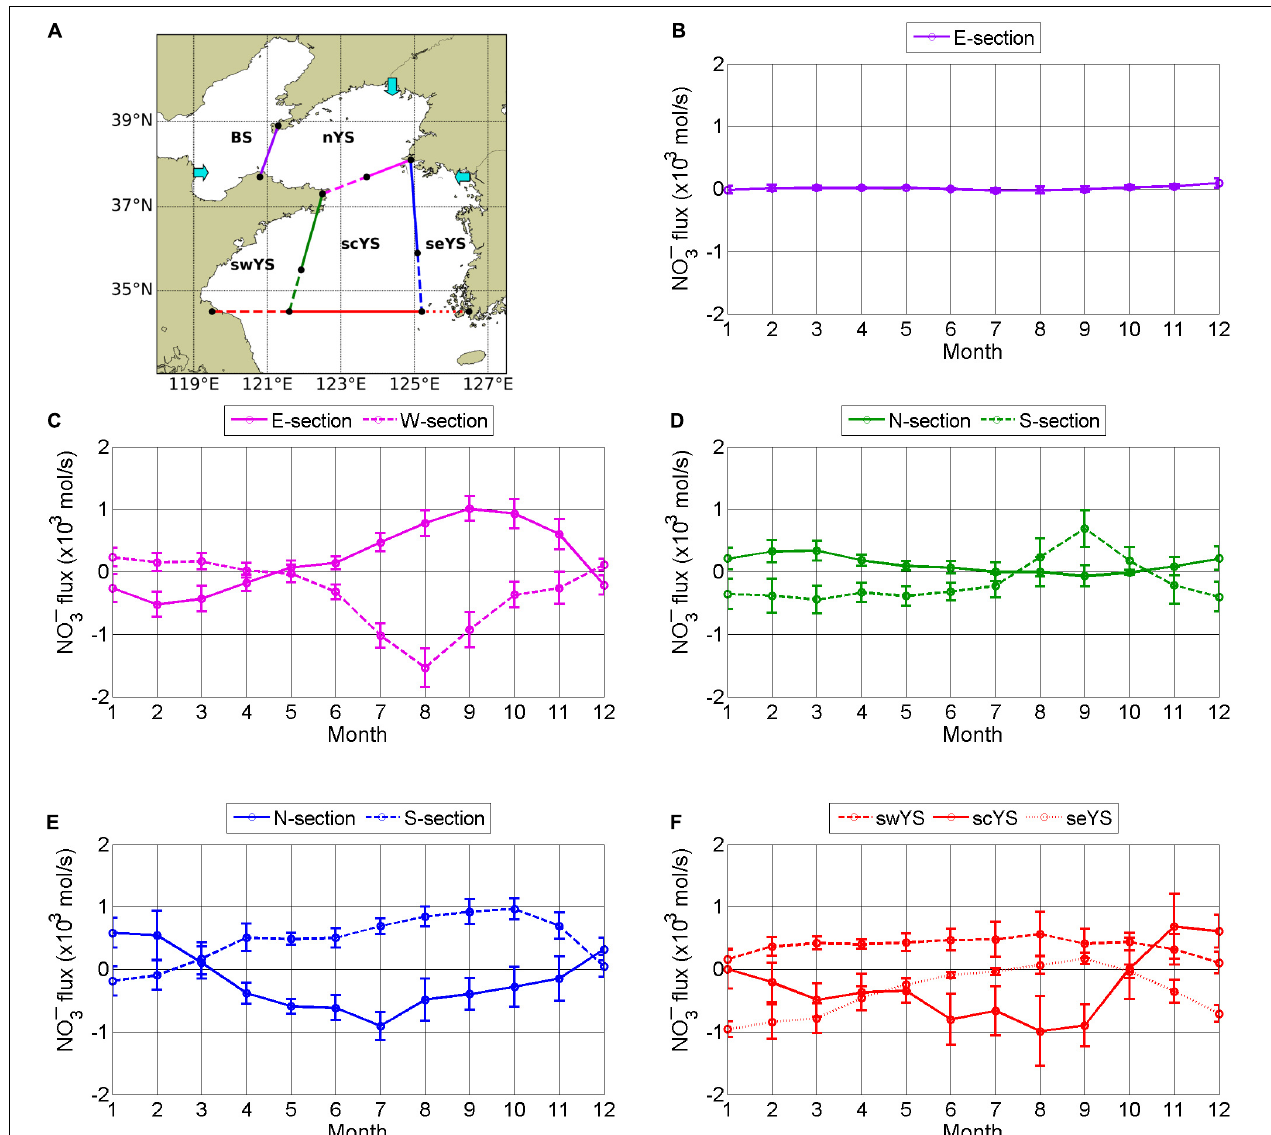
FIGURE 12 | Subregions (A) to estimate NO 3 − flux based on circulation in the YS. BS, nYS, swYS, scYS, and seYS denote the Bohai Sea and the northern, southwestern, southcentral, and southeastern YS, respectively. Cyan arrows indicate NO 3 − flux by rivers from the Korean coast in the seYS, the Yalu River in the nYS, and the Yellow River in the BS. Monthly mean net advective NO 3 − flux between subregions was averaged for the period 2006–2019. The purple (B) , magenta (C) , green (D) , blue (E) , and red (F) lines represent boundaries indicated in (A) ( kmol s − 1 ), where positive values denote eastward and northward fluxes, and negative values denote westward and southward fluxes. YS, Yellow